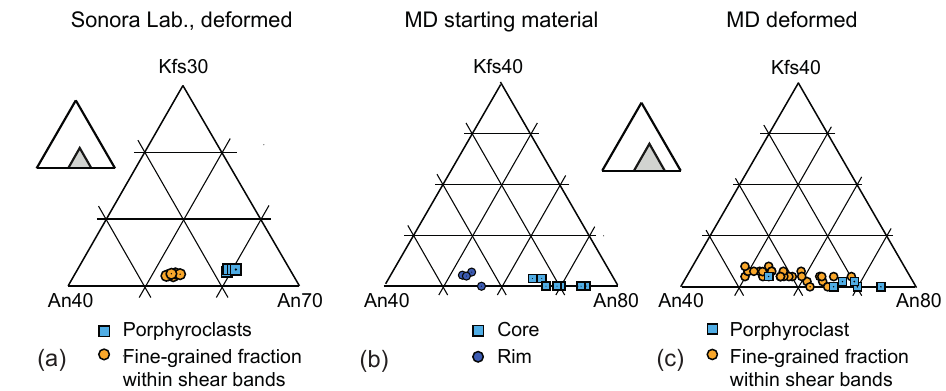
Figure 7. Plagioclase chemical compositions. (a) Sonora labradorite in An60+Di experiment runs. (b) Maryland diabase starting material. (c) Maryland diabase after the experiment. Porphyroclasts vs. small new grain fraction found in shear bands.